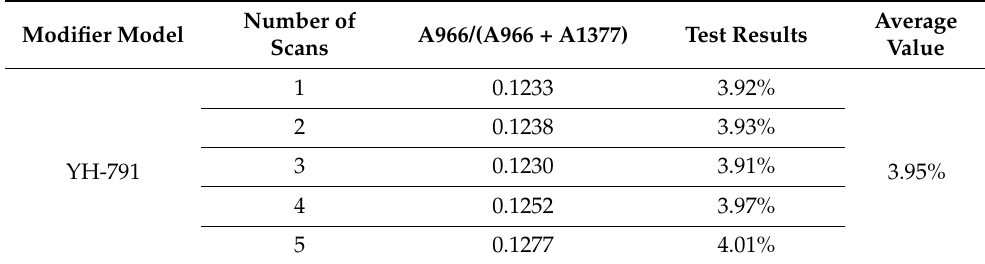
Table 8. Quantitative test results of SBS